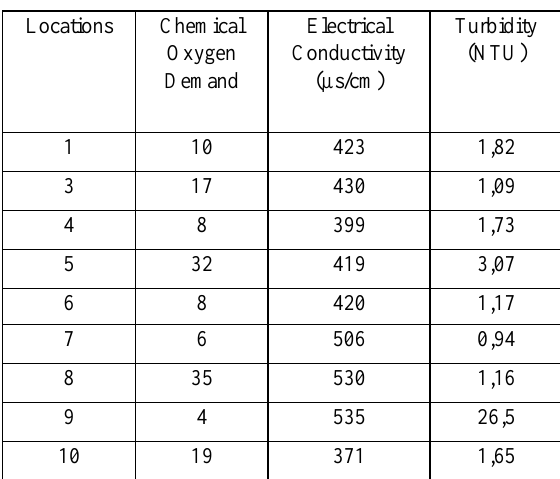
Table 2. Attributes of water sample